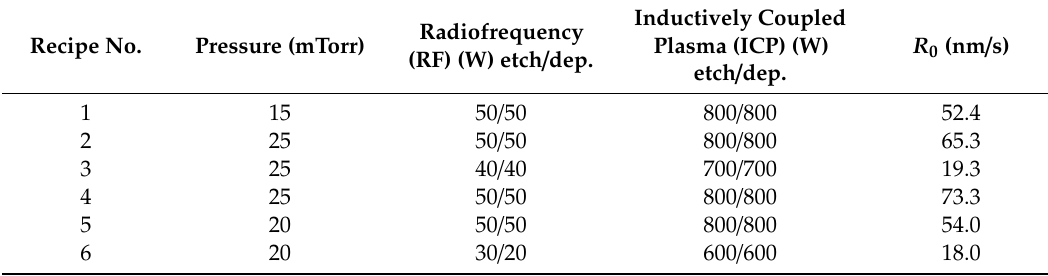
Table 1. Deep reactive ion etching (DRIE) parameters of used recipes in this study. R 0 is defined according to Equation